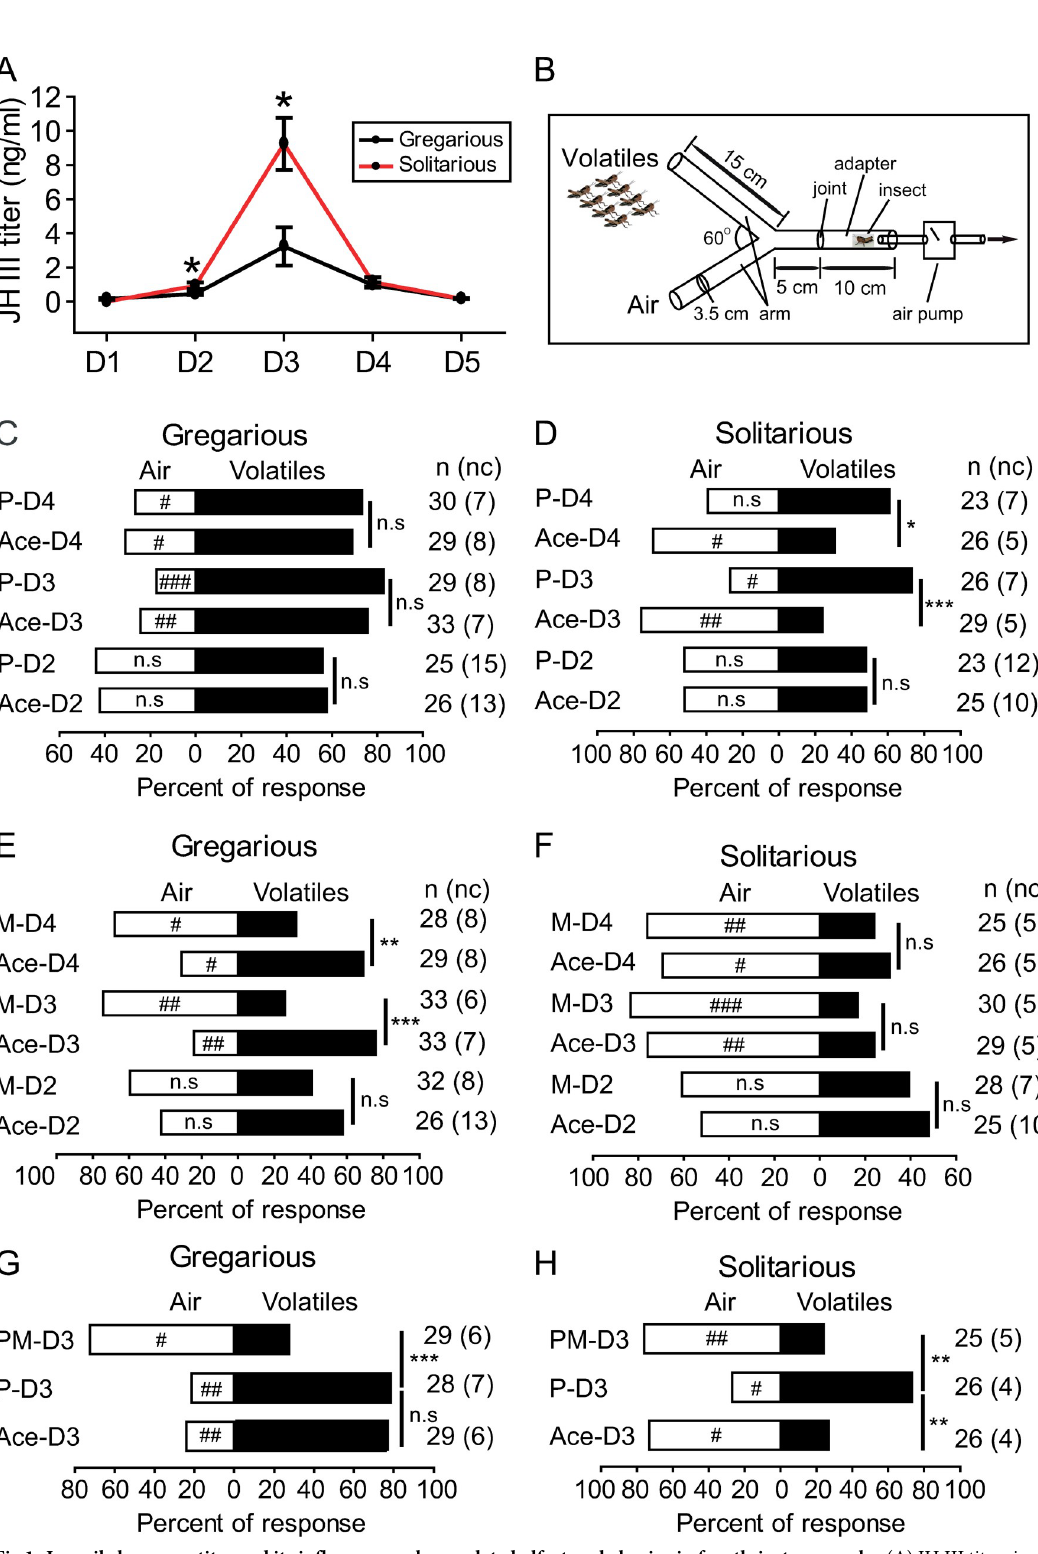
PLOS Genetics | https://doi.org/10.1371/journal.pgen.1008762 April 29,